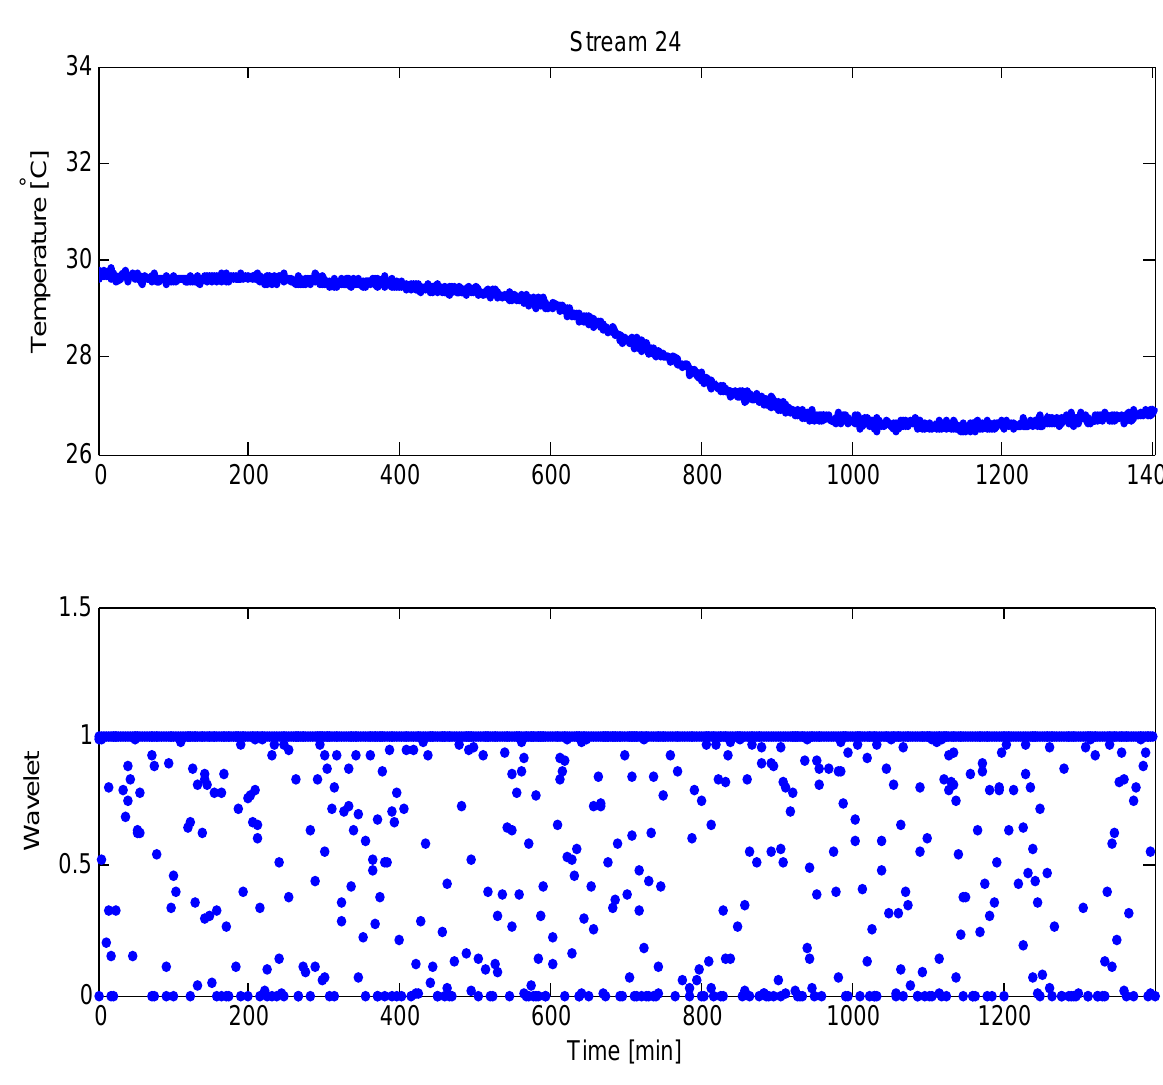
Figure 14. Depropanizer reflux drum case temperature experimental data, in which 5% of Gaussian noise is added to the data, and the SSI results for the wavelet